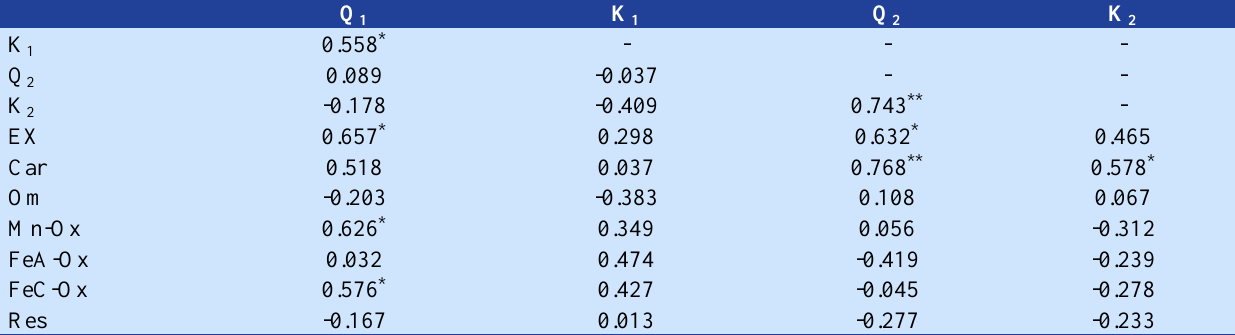
Table 7. Simple correlation coefficients (r) between parameters of the two first-order reaction model of Cr desorption, extracted by EDTA, with Cr